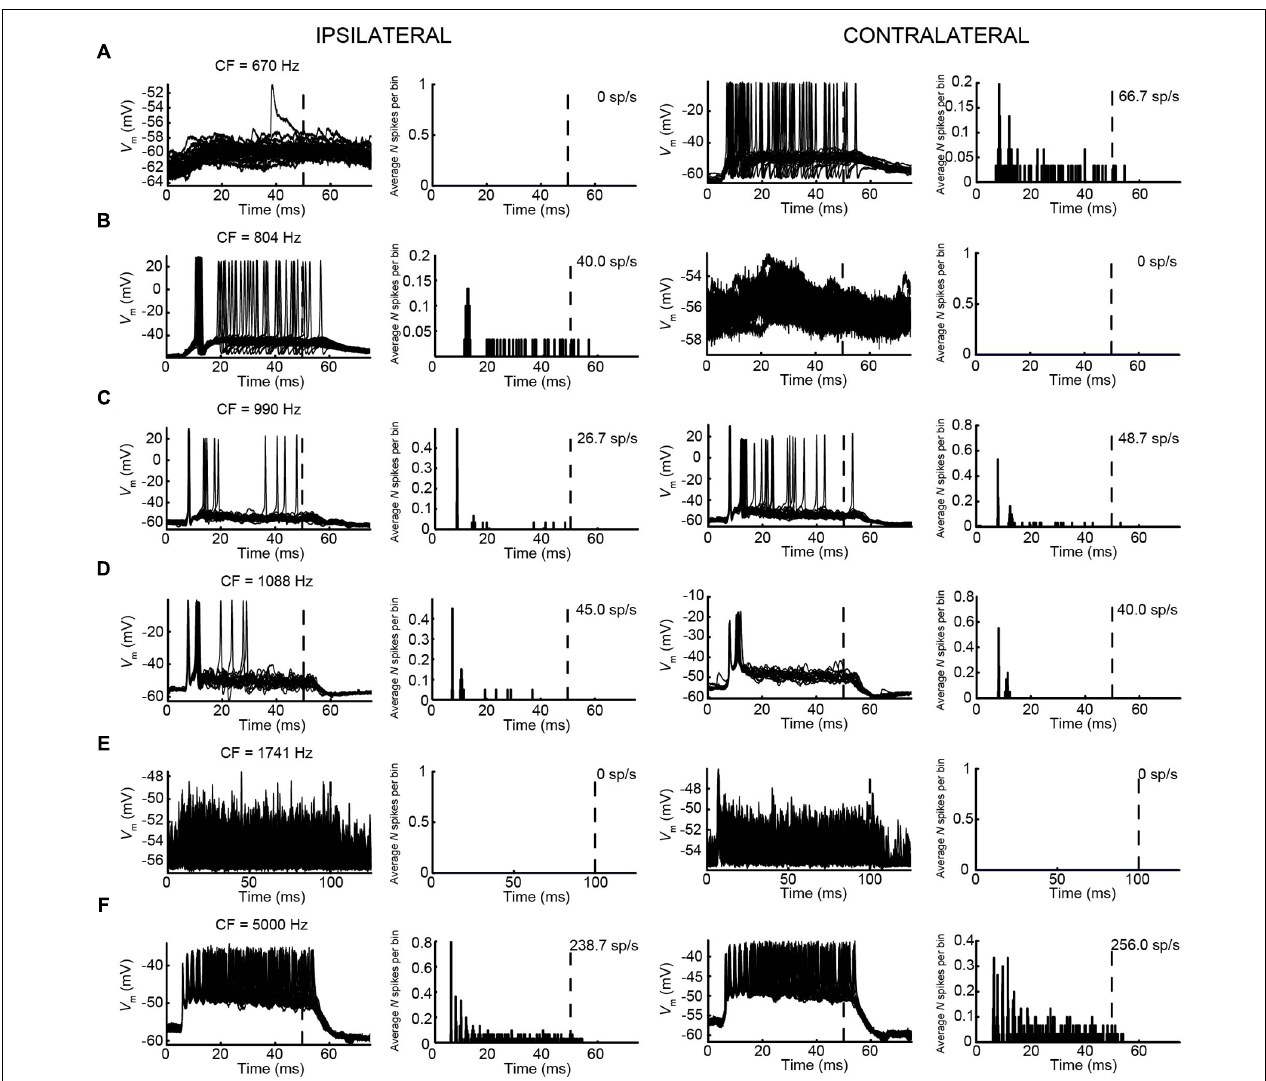
FIGURE 9 | Responses of mLNTB neurons to short tones at CF. V m (left) and PSTH (right) of responses to ipsilateral (two leftmost columns) and contralateral (two rightmost columns) short tones at CF for 6 mLNTB neurons. Bin size = 0.1 ms. Spike rate is indicated for each response. (A) 80 dB SPL/30 repetitions; (B) 85 dB SPL/30 repetitions; (C) 80 dB SPL/30 repetitions; (D) 70 dB SPL/20 repetitions; (E) 70 dB SPL/50 repetitions; (F) 70 dB SPL/30